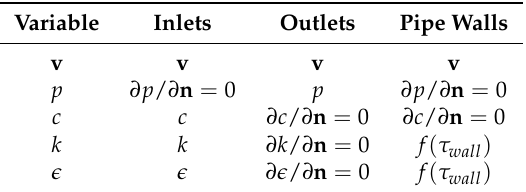
Table 2. Boundary conditions summary for the passive scalar model ( n represents the normal vector) and τ wall refers to the wall shear stress. Variable